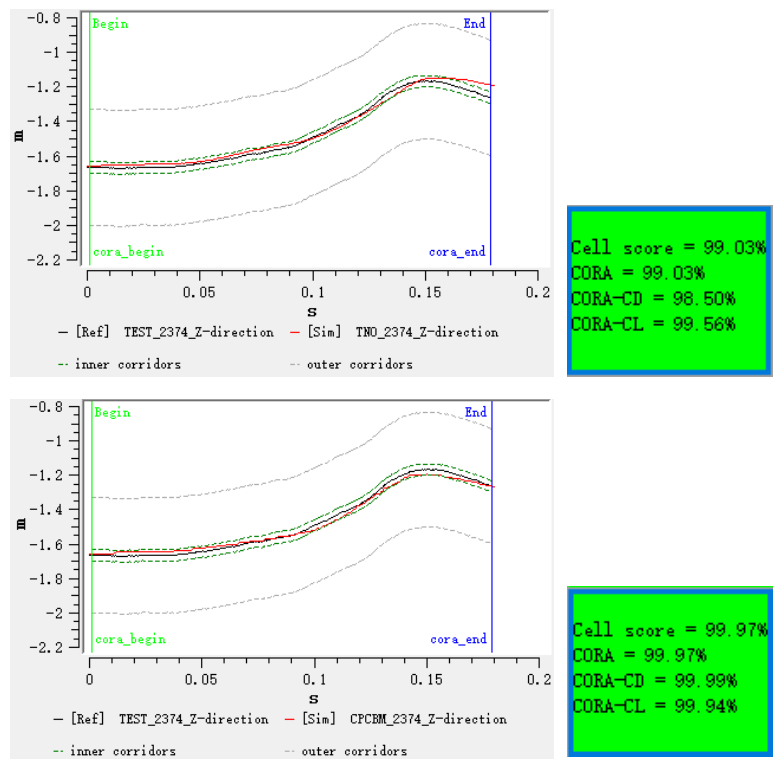
Figure A13. Z-direction displacement signals between experiment and simulation.